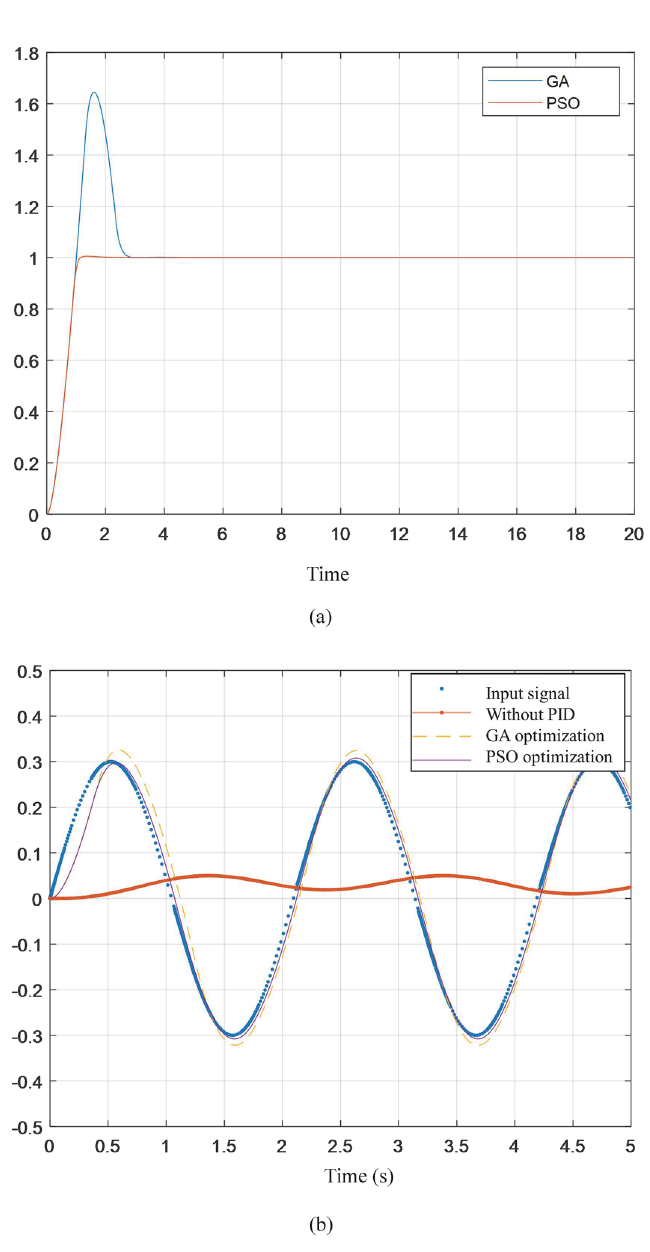
Figure 11. Response curve of the simulation